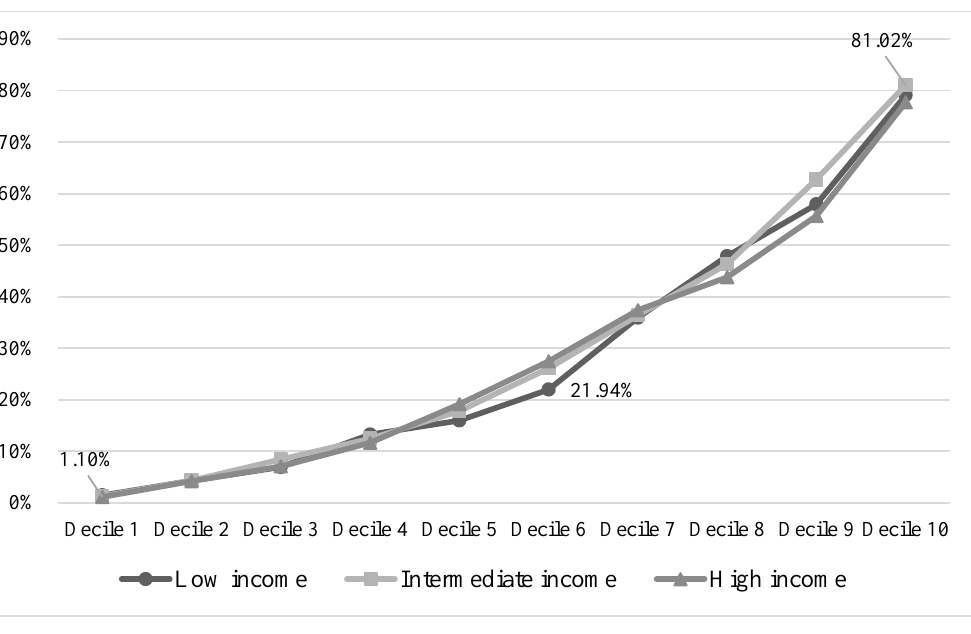
Figure 1: Average predicted probability of purchasing cheap alcohol units (<£0.50) within income and decile groups